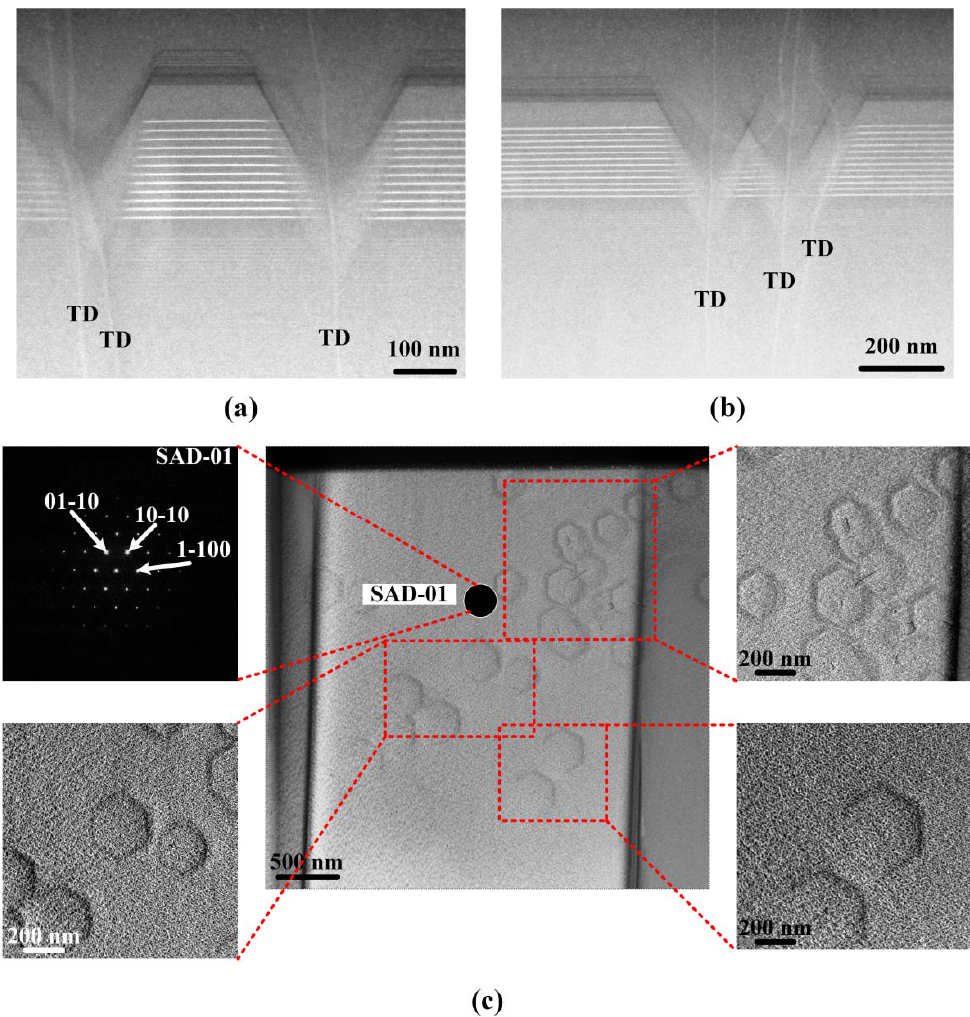
Figure 4. ( a , b ) The HAADF-STEM images showing a representative cross-section of V-pits; ( c ) Plan-view TEM images of a green LED specimen including layers of low temperature p-GaN, InGaN/GaN MQW, and a portion of n-GaN with the selected area diffraction (SAD) pattern of SAD-01. To elucidate the impact of the underlying InGaN/GaN SL on the crystalline quality of the green LEDs, we performed an X-ray diffraction (XRD) measurement on the green LEDs. Figure 5 shows symmetric (002) and asymmetric (102) ω -scan rocking curves of green LEDs without and with an InGaN/GaN SL. The full widths at half maximum (FWHMs) of the symmetric (002) rocking curves of green LEDs without and with an InGaN/GaN SL were about 265 and 165.5 arcsec, respectively. The FWHMs of the symmetric (102) rocking curve of green LEDs without and with an InGaN/GaN SL were about 194.2 and 181.5 arcsec, respectively. The FWHMs of symmetric (102) and (002) rocking curves of green LEDs with an InGaN/GaN SL are much smaller than those of green LEDs without an InGaN/GaN SL. We can reasonably conclude that the green LED with an InGaN/GaN SL has superior crystallite quality as compared with the green LED without an InGaN/GaN SL.